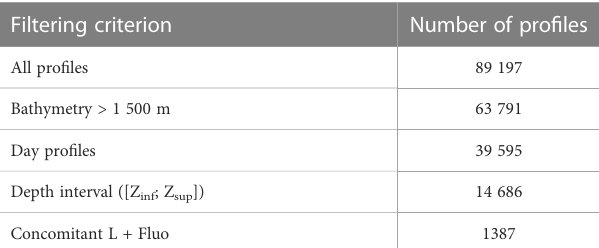
TABLE 2 Dataset selection criteria and number of selected PAR pro fi les. Filtering